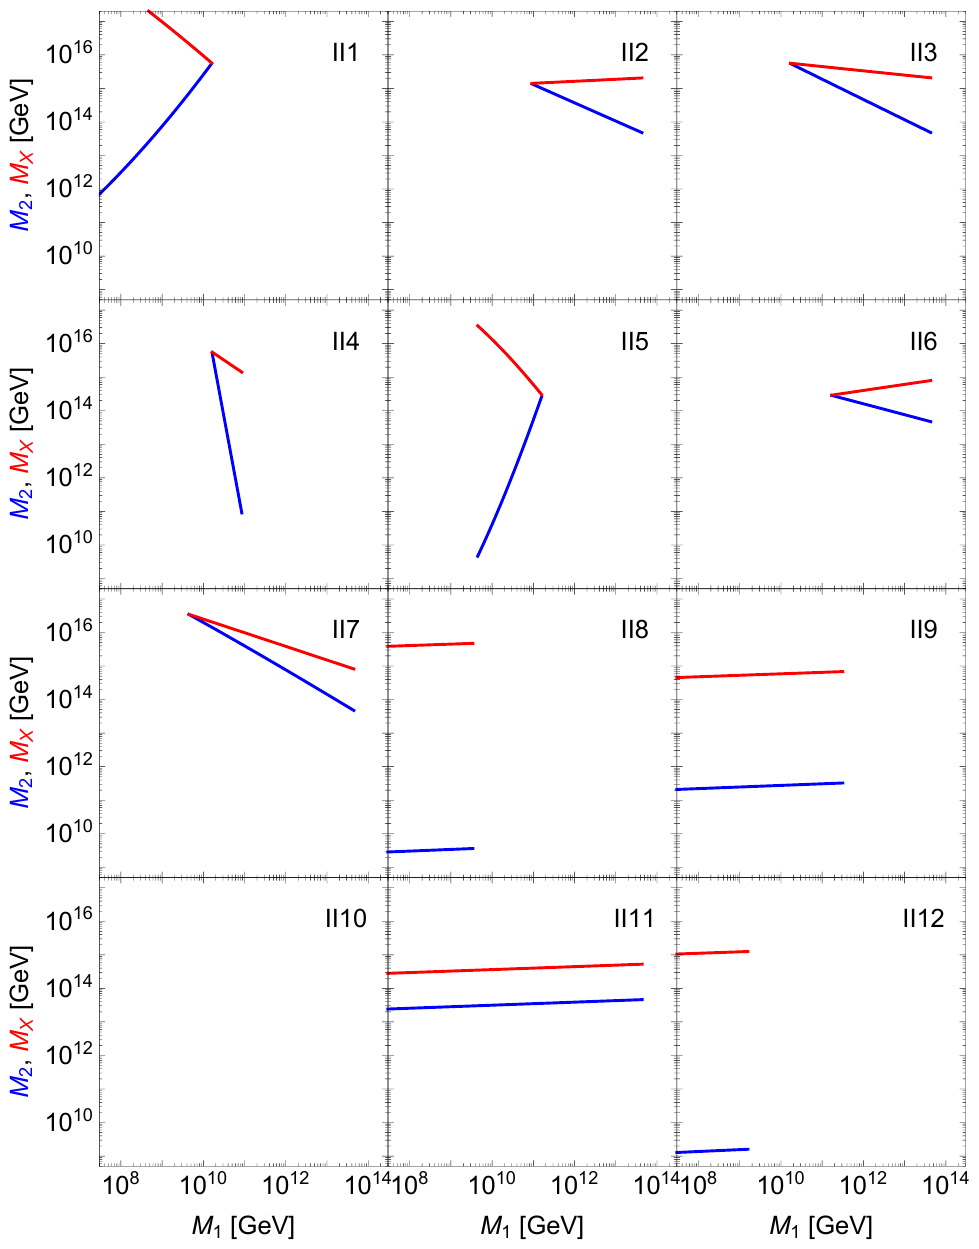
Figure 1 . Predictions of GUT scale, M X , and intermediate scale, M 1 , and M 2 , for breaking chains with two intermediate scales: SO(10) → G . Chain II10 is excluded as 2 → G 1 → G SM there exists no solution for gauge unification. We set the lower and upper bound on the mass scales to be M = 5 × 10 7 GeV and M in the scan respectively. The energy scale ordering low pl M low 6 M 1 6 M 2 6 M X 6 M pl is required in all